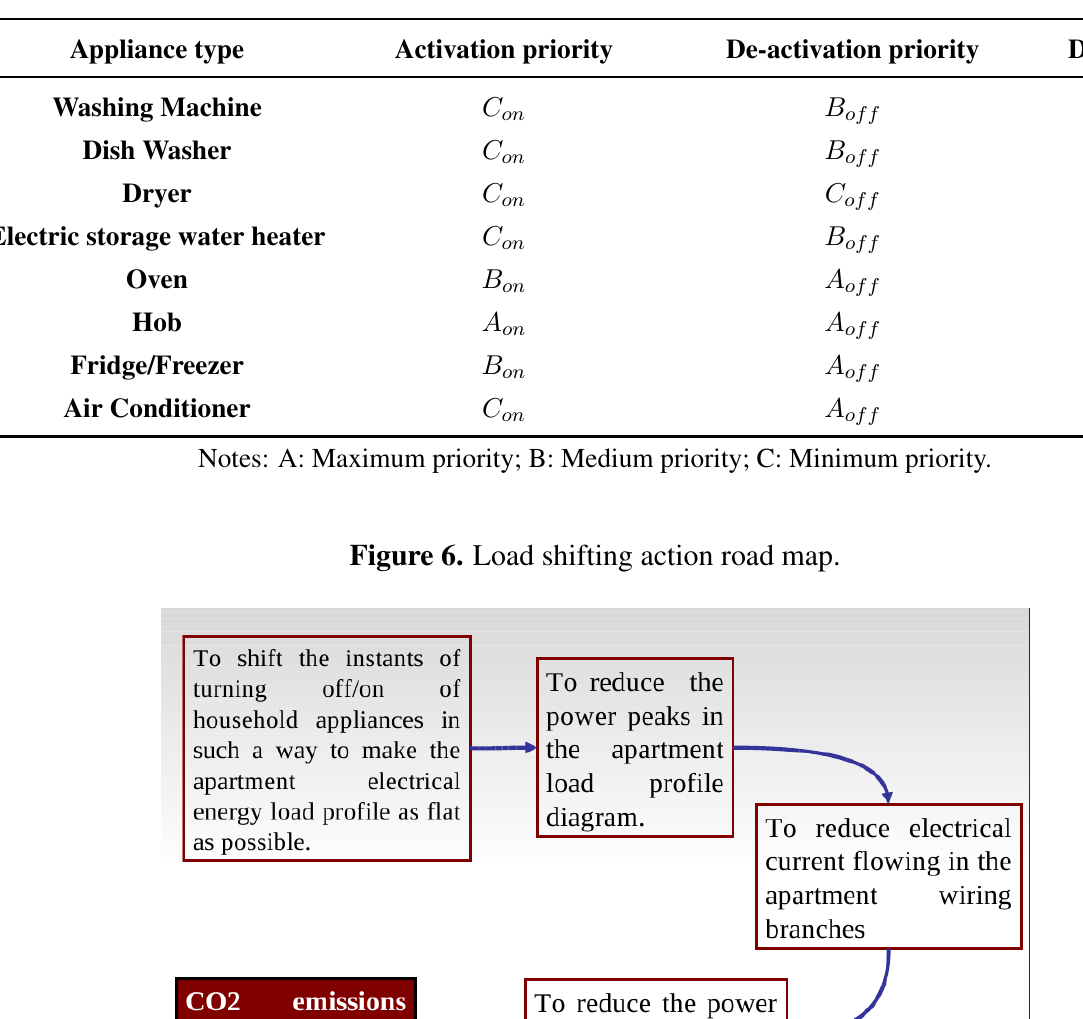
Table 1. Load shifting.